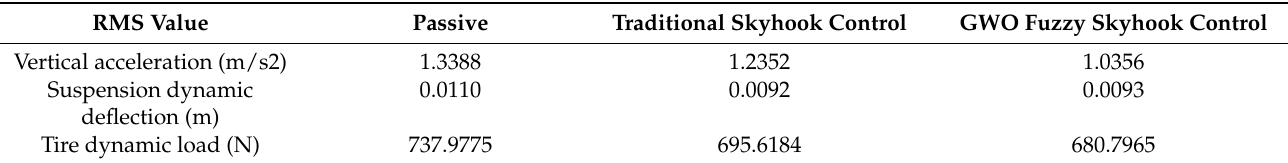
Figure 19. Potholed road excitation simulation signal. The time histories and RMS values of the body vertical acceleration, suspension dynamic deflection, and tire dynamic using three control methods under potholed road excitation are shown in Table 5 and Figures 20–22. Table 5. Body vertical RMS acceleration, the suspension dynamic deflection, and the tire dynamic load under potholed road excitation. RMS